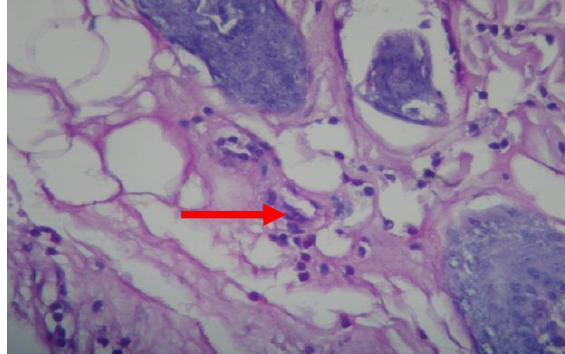
Figure, 9b: section in the skin of non- immunized animal at day 30 post challenge showed eosinophilic infiltration in hypodermis with appearance of some destructed follicle (PAS stain